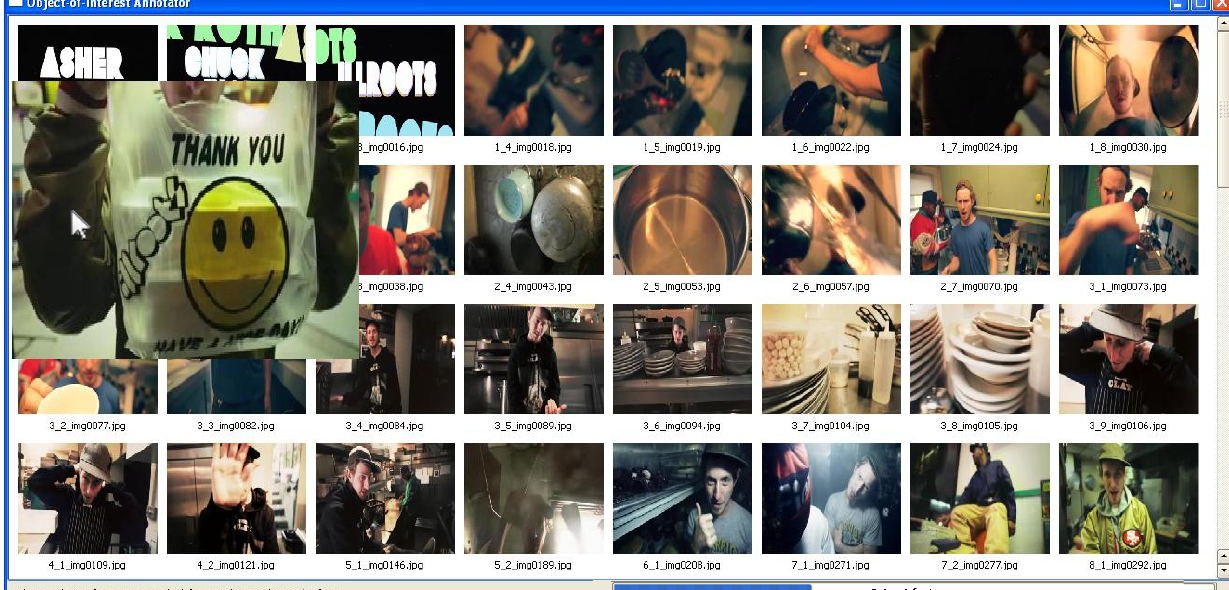
Figure 9. Object-of-interest selection in the annotation prototype (under the mouse cursor).